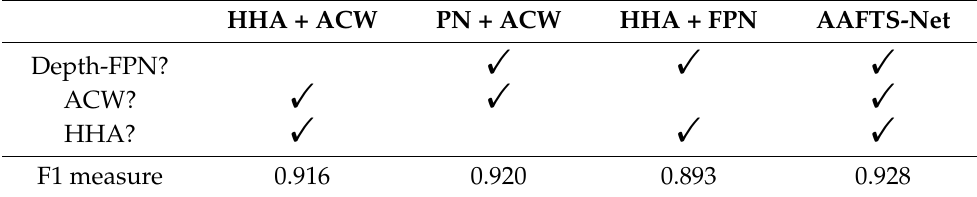
Table 5. Evaluation of the contributions of each important component of